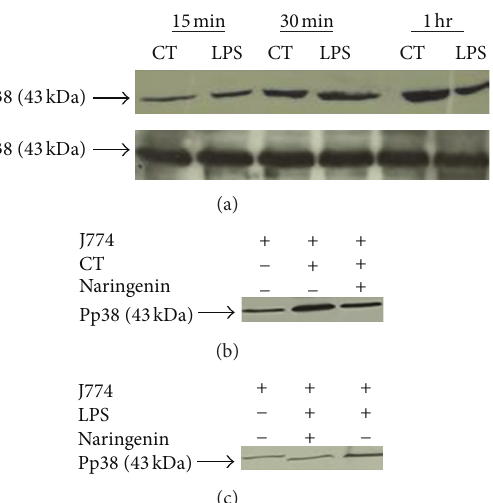
Figure 6: Naringenin downregulates the phosphorylation of p38 MAPK in C. trachomatis infected mouse J774 macrophages. Macrophages ( 3 × 10 6 cells/well) were seeded in 6-well plates and then infected with C. trachomatis (3 × 10 5 IFU/well) or LPS (3 𝜇 g/well). After infection of macrophages, protein lysates were collected as indicated in Section 2. The presence of total p38 (p38) (internal control) and phosphorylated p38 (Pp38) was determined by western blotting. Shown are the band intensities for internal control and pp38 at different time points for macrophages treated with C. trachomatis (CT) and LPS (a). Blots shown in (b) and (c) were developed 1h after exposing macrophages to CT or LPS in the presence and absence of naringenin. The 43kDa Pp38 and p38 proteins were determined from a known biotinylated protein